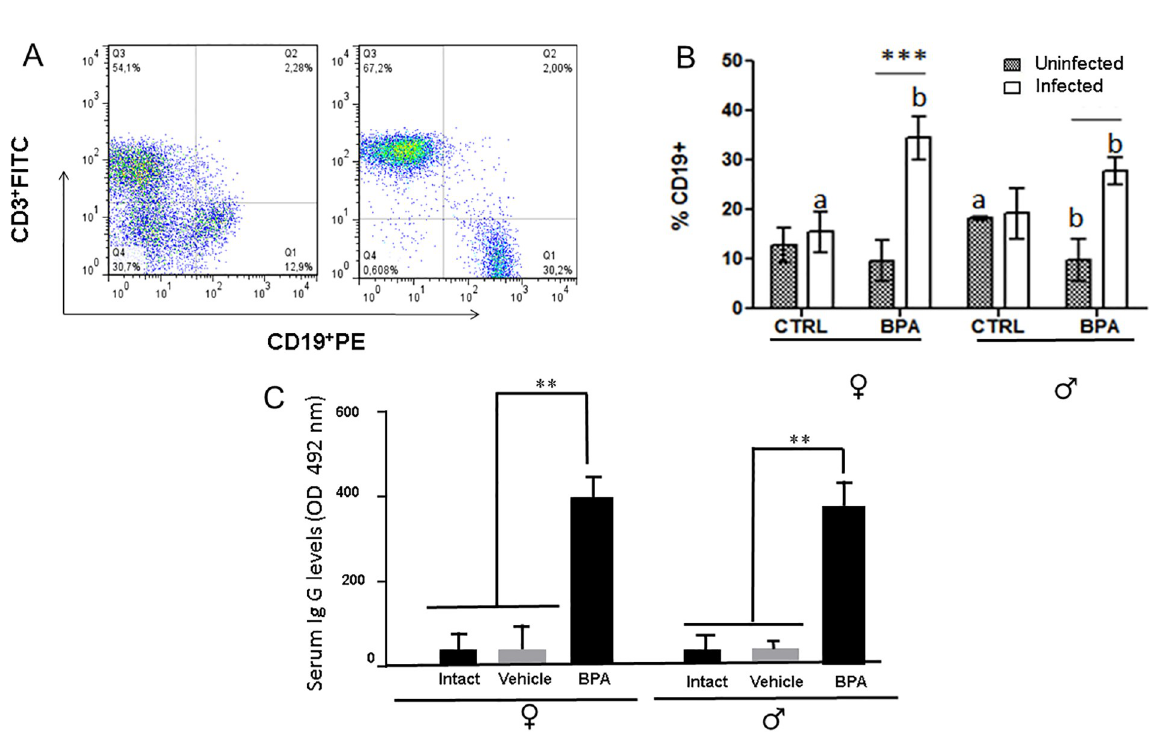
Fig 5. Analysis of B cell subpopulations frequencies by flow cytometry, ( a ) Representative dot-plot of cytometric analysis algorithm of B cells (CD3 - CD19 + ). The graph represents the frequencies of B cells (b) . The levels of anti T . spiralis antibodies are depicted in ( c ). Literals-ANOVA